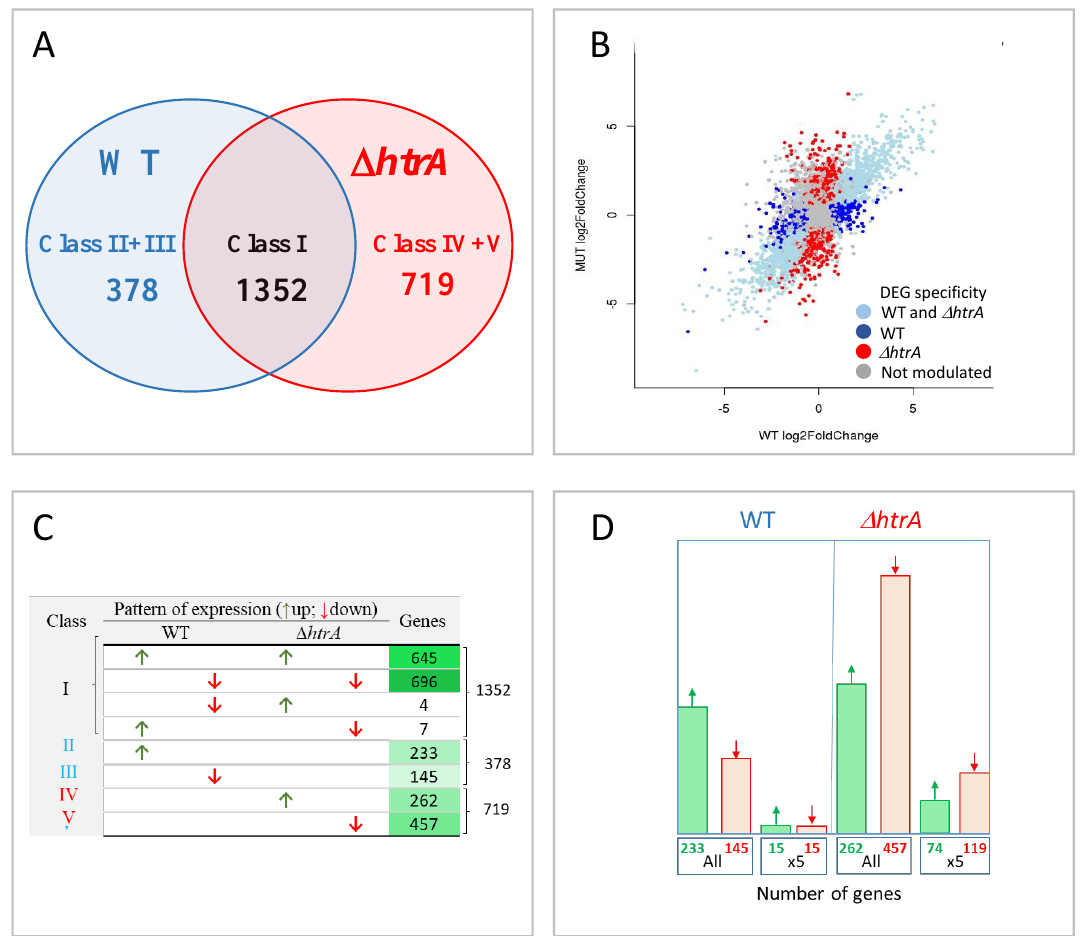
Figure 3. ( A ) Venn diagram of the three major categories of DEGs. Number of genes whose pattern of expression is modified by the H 2 O 2 treatment in both strains (Class I), in the WT strain (classes II and III), or in the ∆ htrA strain (Classes IV and V) is indicated. ( B ) All genes expression pattern scatterplot of log2 fold change. Each dot represents an individual gene; its x value is the log2 fold-change in the WT, and its y values is the log2 fold-change in the ∆ htrA strains, before and after H 2 O 2 treatment. Dot color significance: gray dots represent genes exhibiting a pattern of expression not modified by stress; blue dots represent genes modulated in the WT strain only; red dots represent genes modulated in the ∆ htrA strain only; light blue dots represent genes modulated in both strains. Note the diagonal trend of the scattered dots in the latter category (light blue) indicating that these genes exhibited a similar pattern of modulation in both strains. ( C ) Number of genes in each of the 5 Classes of DEGs. Upregulation and downregulation of genes are indicated by green ascending arrows or red descending arrows, respectively. Note that Class I genes comprise all the genes which exhibited a modified pattern of expression in both strains, both upregulated and downregulated; the vast majority of the genes in this class exhibited either upregulation or downregulation in both strains, and only a minority exhibited an inverted pattern. A green color gradient was applied to the table-cells in the right column according to the number of genes in each class. ( D ) Histograms representing the number of Class II and III (left panel, WT-specific modulated genes) and classes IV and V (right panel, ∆ htrA -specific modulated genes), as calculated by considering all the significantly modulated (indicated as “all”) or by a more stringent 5-fold modulation index (indicated as “ × 5”). An adjusted p value of < 0.01 was applied. Histograms of upregulated genes are green, those representing downregulated genes are